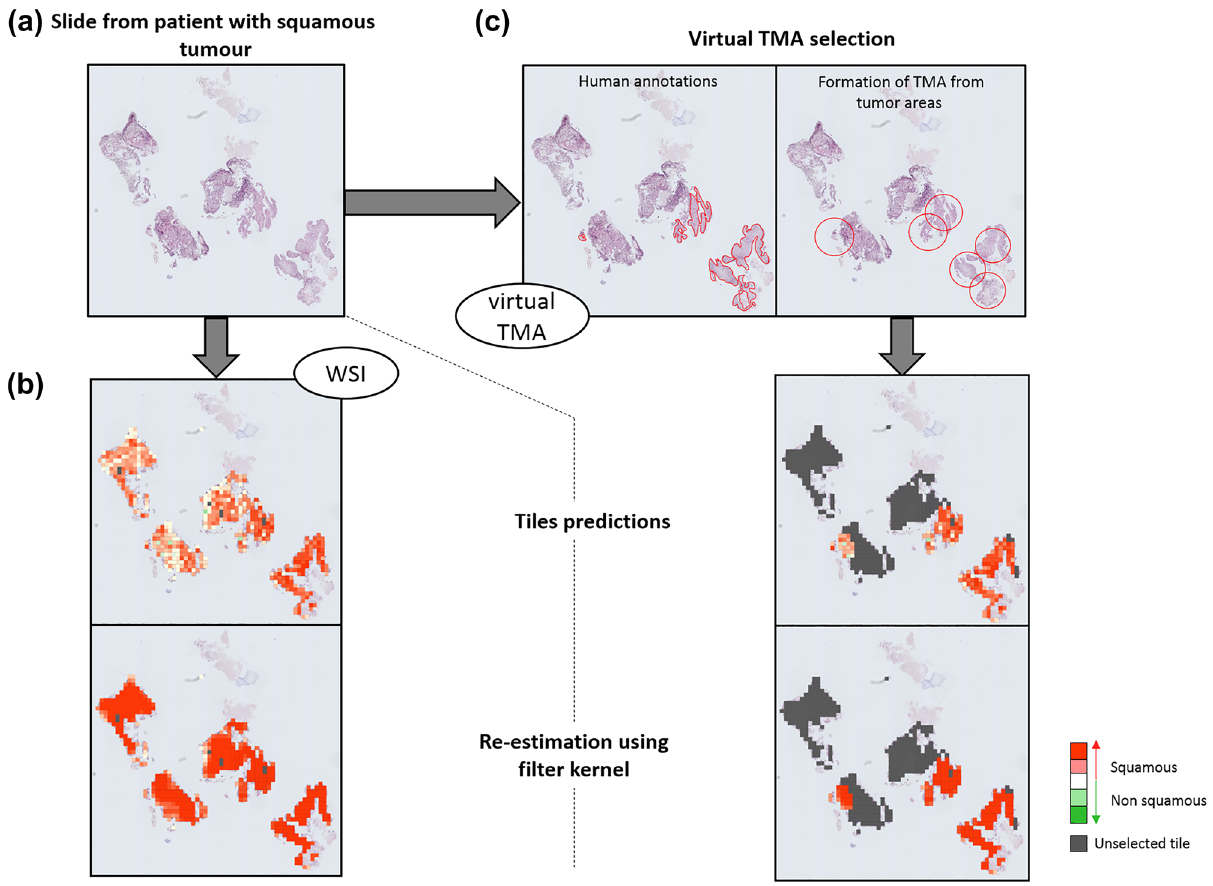
Figure 2. Prediction procedure for a squamous tumour biopsy section. ( a ) Representation of original slide. ( b , c ) Steps for prediction analysis based on (b) Whole Slide Image (WSI) or ( c ) virtual TMA strategy. Heatmaps show for each tile probability of being predicted as squamous tumour (red) or non-squamous tumour (green); the highest probability was kept for coloration; grey was used for tiles non selected by the pathologist or removed by denoising step (tile containing more than 2/3 of white